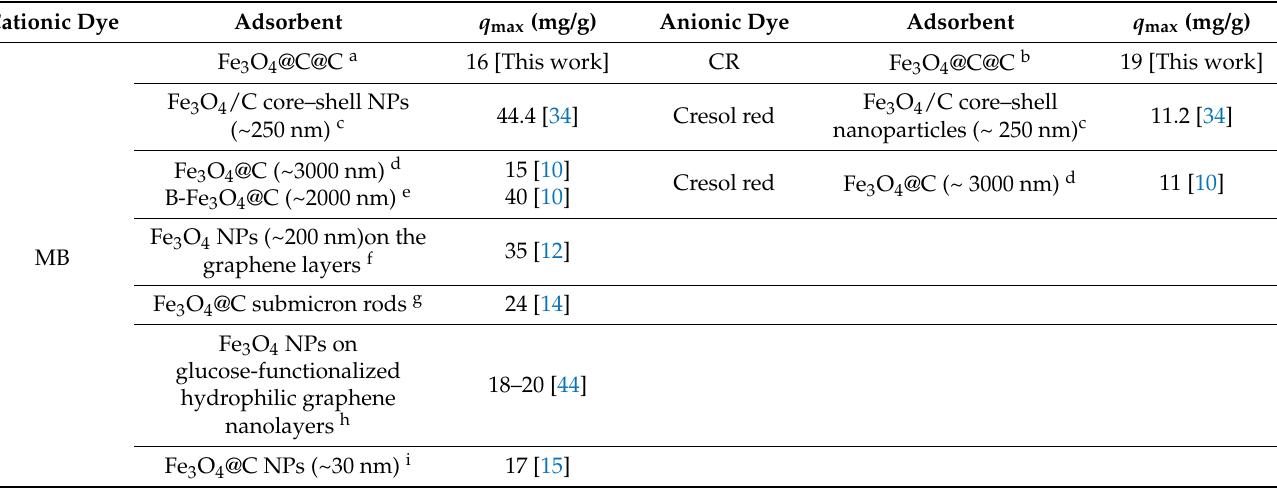
Table 4. Comparison of the adsorption capacity of the Fe 3 O 4 @C@C NPs for the anionic and cationic